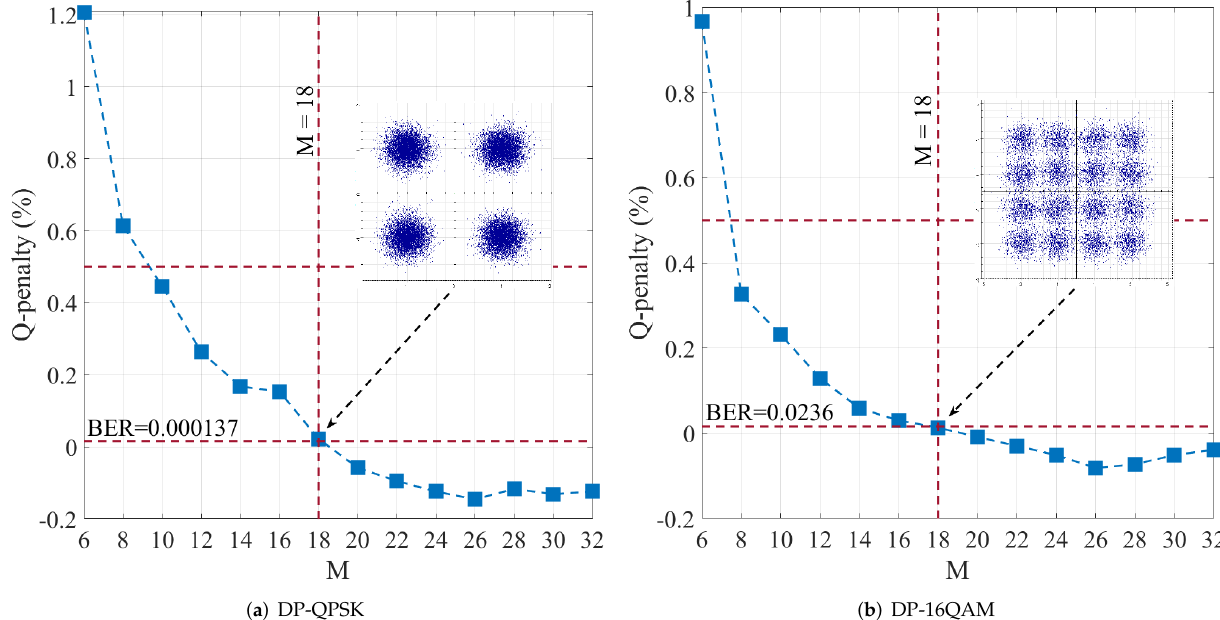
Figure 7. The Q-penalty performance of the DP-QPSK and DP-16QAM data. We compare the filters of the TD-CDE FIR filter and the CQWO-TD-CDE FIR filter under different quantization stages M. ( a ) Q-penalty curve under the DP-QPSK, and the fiber transmission distance is 1000 km. ( b ) Q-penalty curve under the DP-16QAM and the fiber transmission distance is 700